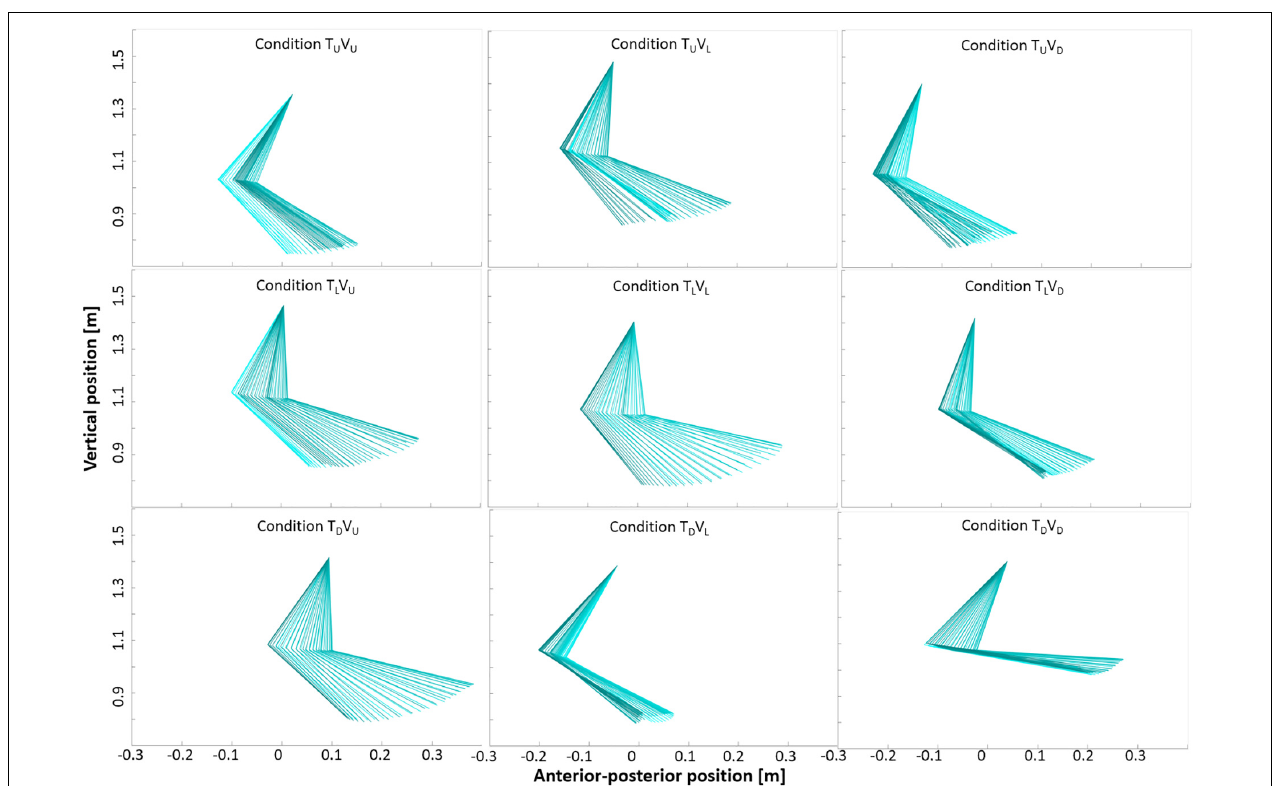
FIGURE 8 | Arm and forearm movement in the nine experimental conditions. Sagittal plots of right upper-limb angles in one representative participant during a single gait cycle taken from 0 to 20 s post-transition (incongruent conditions) and from stable walking (congruent conditions: 48–60 s post-transition). Data from the shoulder, elbow and wrist defined the two segments of arm and forearm. See Table 1 for joint angles. Darker color indicates backward movement, and lighter color indicates forward movement. Visual cues appear to influence upper-limb movement during incongruent conditions in a manner consistent with the (visually) corresponding congruent condition. For example, in the middle row, incongruent conditions T L V U and T L V D approach the shape of congruent conditions T U V U and T D V D ,